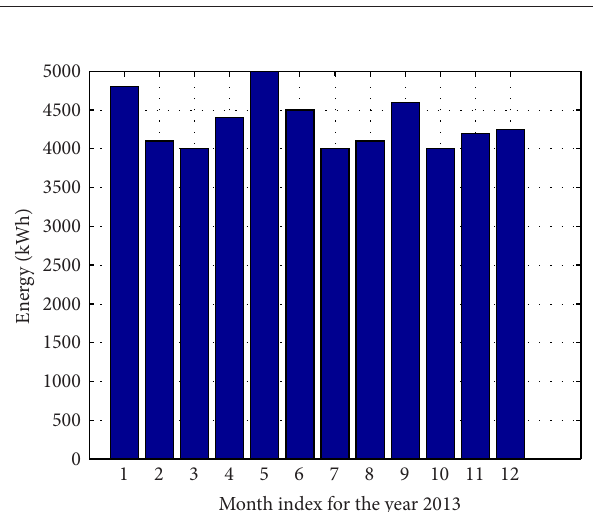
Figure 4: Energy consumed by a school complex at Accra for the year